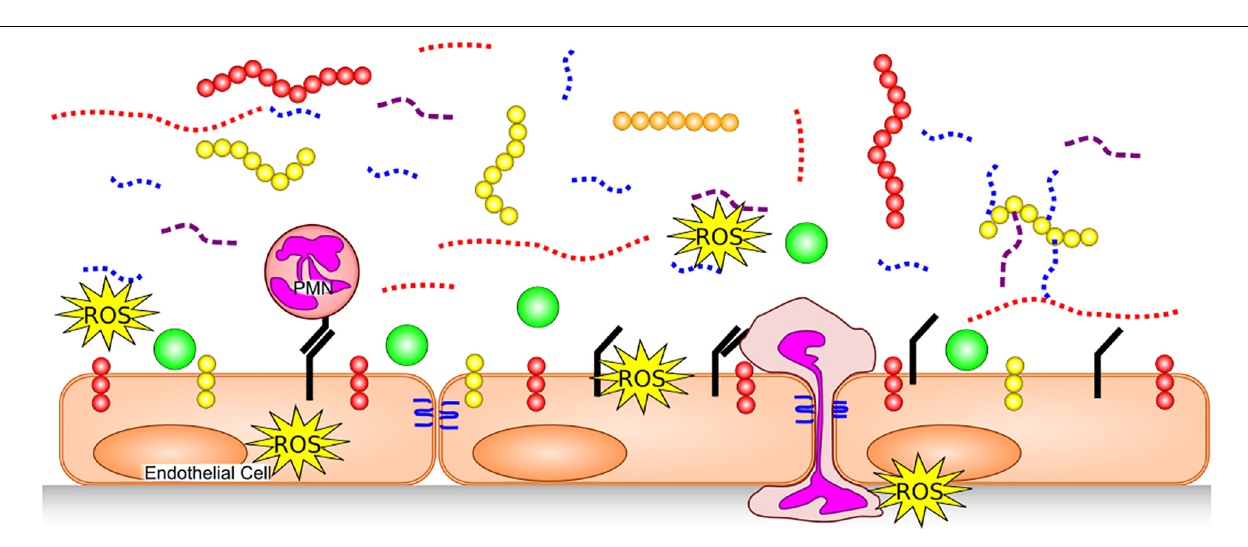
FIGURE 2 | Glycocalyx Degradation. The endothelial glycocalyx is degraded by proteases [which remove core proteins’ ectodomains: syndecans (yellow), glipicans (orange) and CD44 (red)], GAG-degrading enzymes and ROS, leaving free fragments of HA (red dotted), HS (blue dotted) and CS (purple dashed). This exposes cellular adhesion molecules (black) on the endothelial surface, allowing easier binding of white blood cells [e.g., neutrophils (PMNs)] and platelets. Neutrophils can release additional proteases, further damaging core glycocalyx proteins, junctional proteins (blue) and produce additional ROS. With a degraded glycocalyx, blood flows closer to the endothelial cells and plasma proteins (green), can access the endothelial